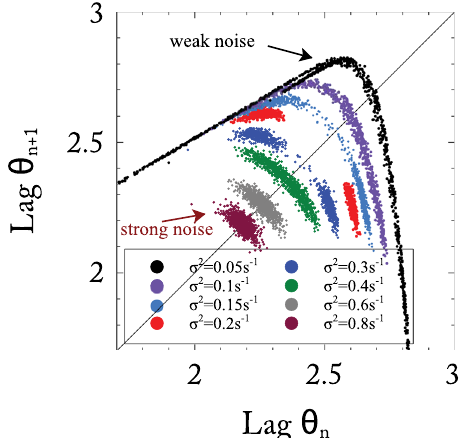
Figure 6. The iterated map for the lag θ n of a periodically forced IF-network exhibits a period-doubling bifurcation (cf. Fig. 5). Different colors show θ n -sequence for one initial condition for different values of the noise σ 2 . With increasing σ 2 the dynamics go from disordered to a noisy 2-cycle to a noisy fixed point. Parameters as in Fig. 4 except for N α = 5,000, ρ (2) = 1.03, γ 0 = 0.81, g syn = 4.2 × 10 − 5 .